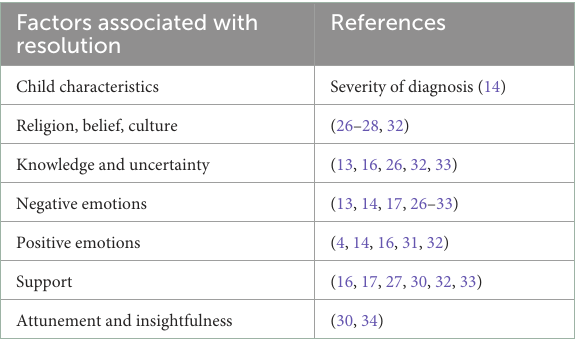
TABLE 2 Factors associated with